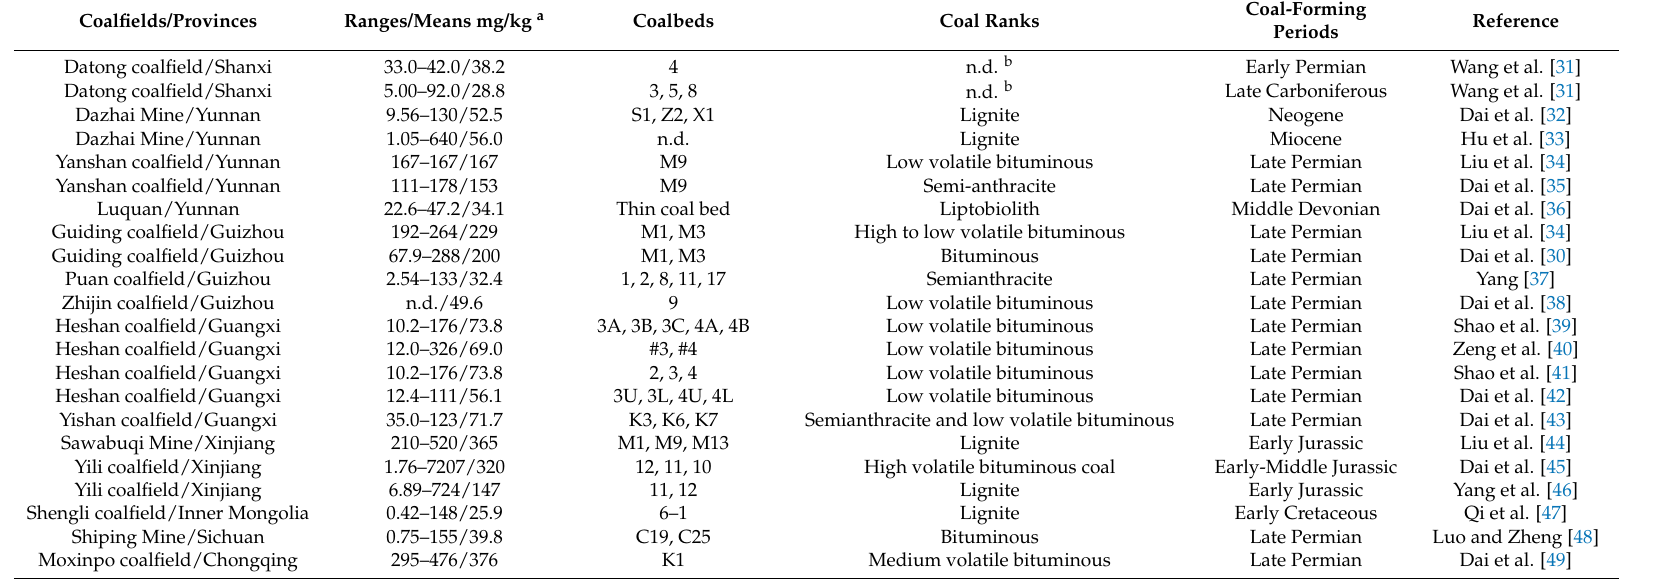
Table 1. Significantly uranium-rich coals in